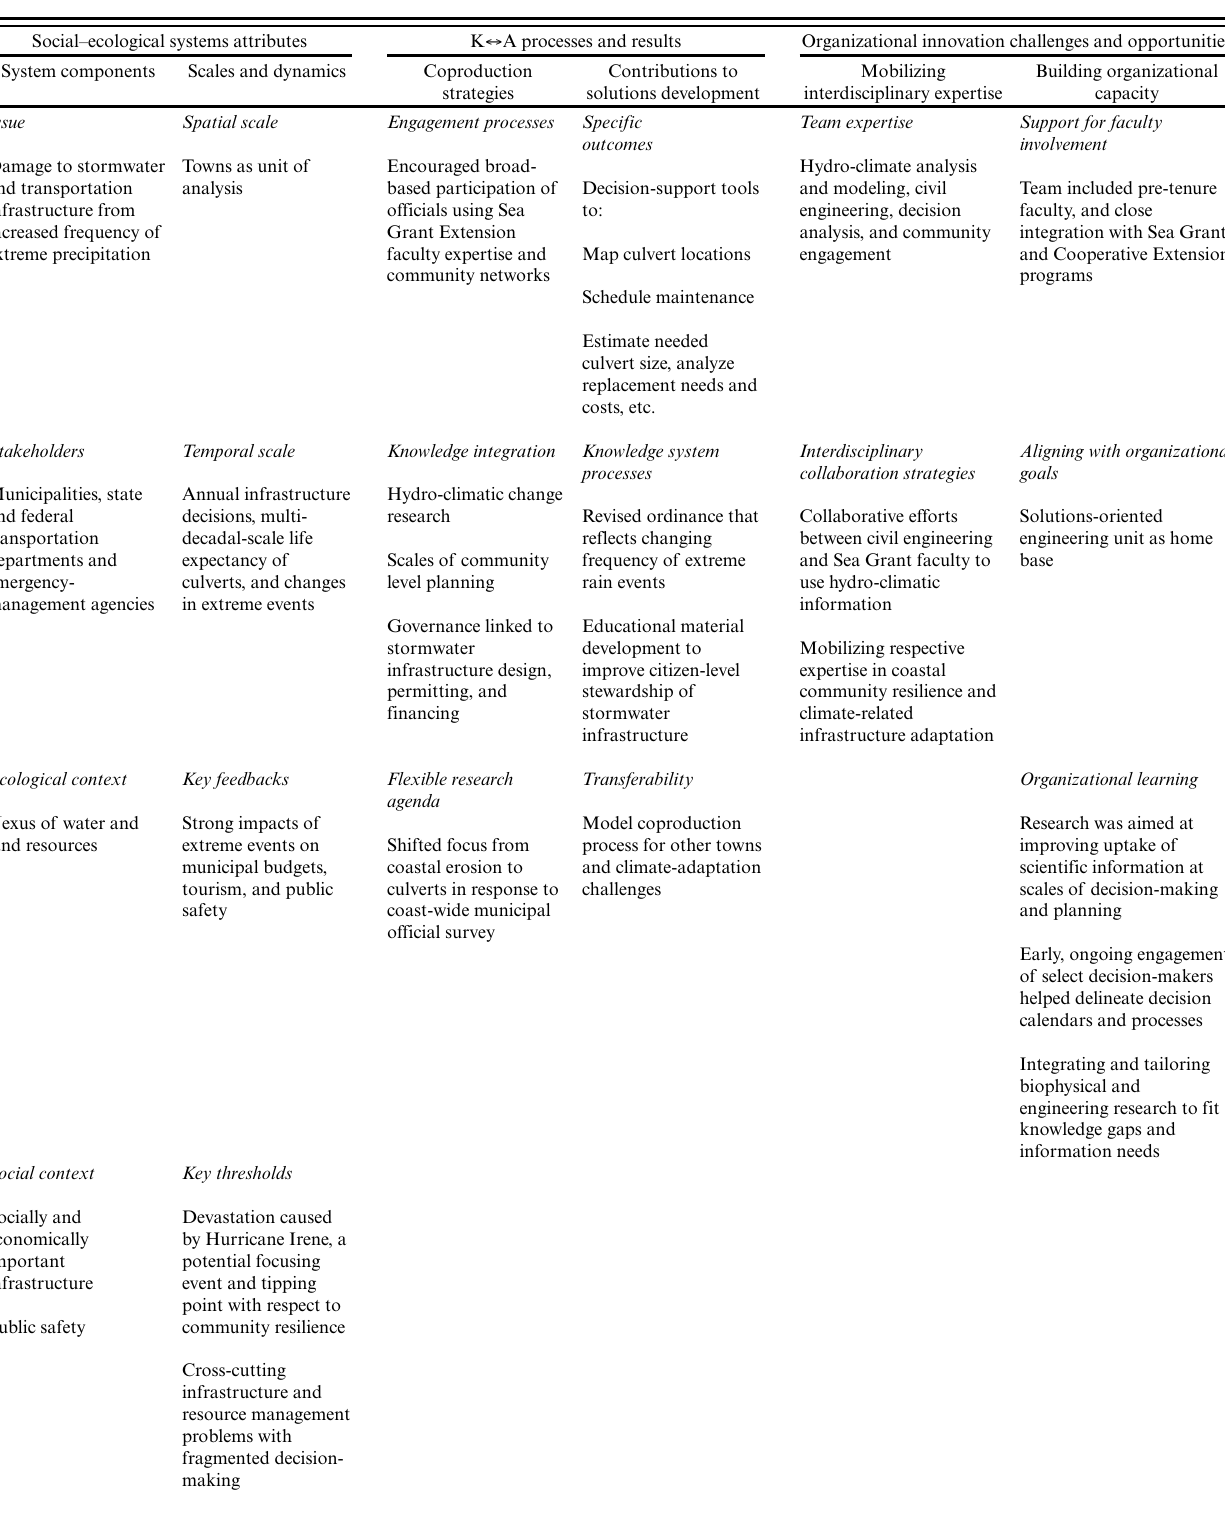
Table 2 . Major characteristics of three solutions-focused research projects: coastal adaptation. Social–ecological systems